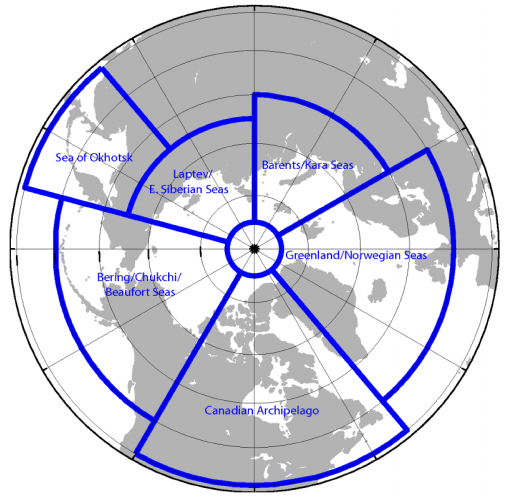
Figure 7. Analysis regions used for the NIC ice edge comparison shown in Tables 1–3.